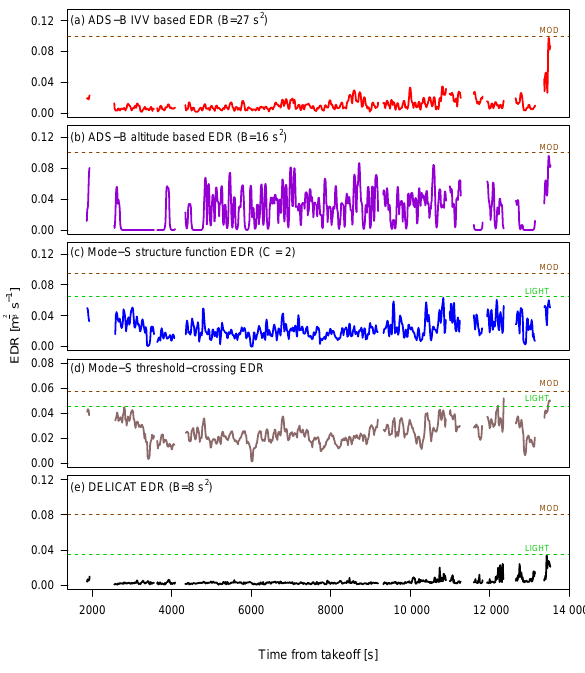
Figure 8. Results for FL6 for all analysed approaches to estimate EDR and a reference EDR (as in Fig. 2). The time series are scaled to match the intensity of the FL9 MOD event. For reference the indicative turbulence levels have been added to the plot. Those are reflecting the FL9 encounters and levels of noise inferred from the calm